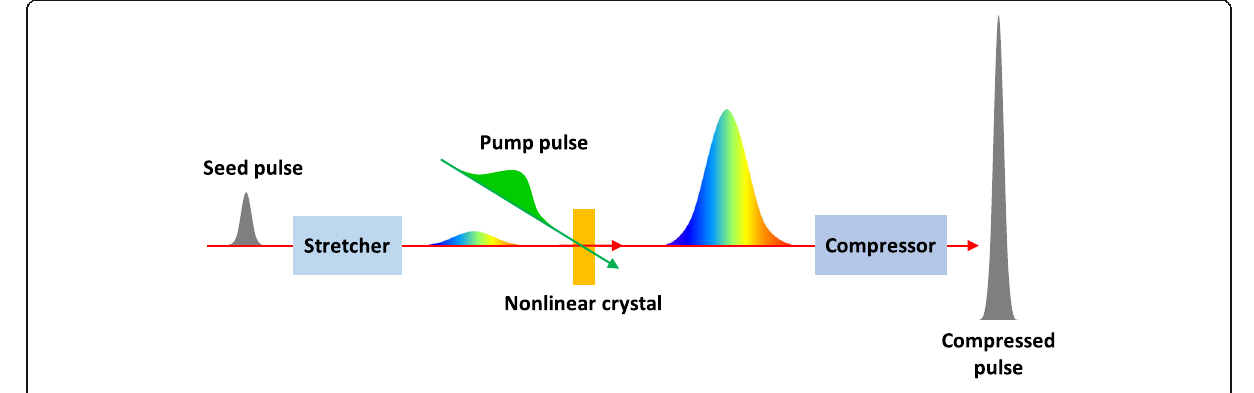
Fig. 5 Concept of optical parametric chirped pulse amplification